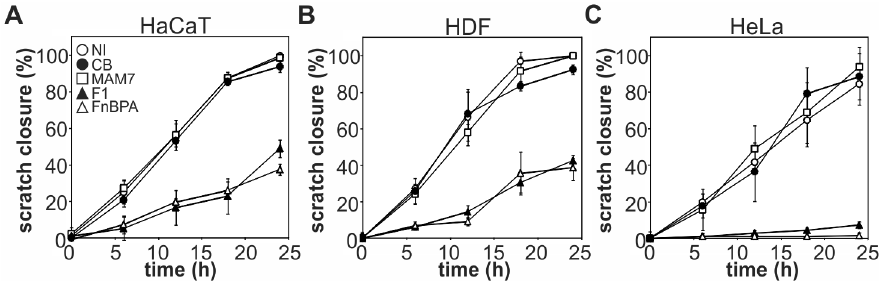
Figure 3. Effects of adhesion inhibitors on the rate of scratch closure. Experiments were performed as depicted in Figure 2 and scratch closure on confluent layers of HaCaT (A), HDF (B) or HeLa cells (C) was determined at t=0, 6, 12, 18 and 24 hours post scratch. Scratch width at 24 hours post scratch was defined as 100 % closure. Results are means ± standard deviation from one of a set of three experiments done in triplicate wells, with three frames taken per well. NI, no inhibitor present (open circles); CB, GST- immobilized control beads (black circles), MAM7, bead-immobilized MAM7 peptide (open squares); F1, bead-immobilized FUD peptide (closed triangles); FnBPA, bead-immobilized FnBPA (open triangles).